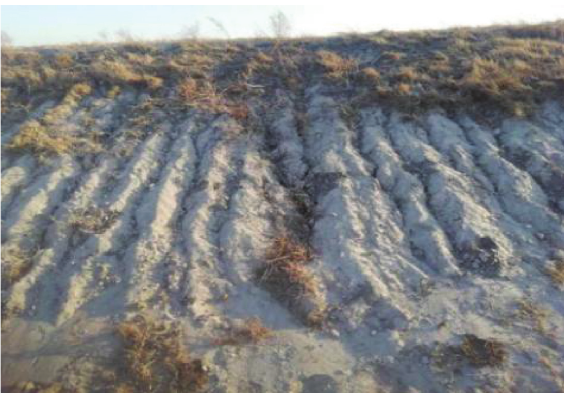
Figure 11: Slope erosion of dispersive soil embankment.